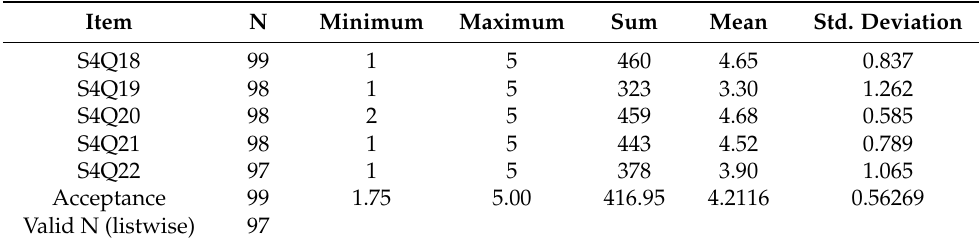
Table 5. Descriptive statistics of perception of the acceptance